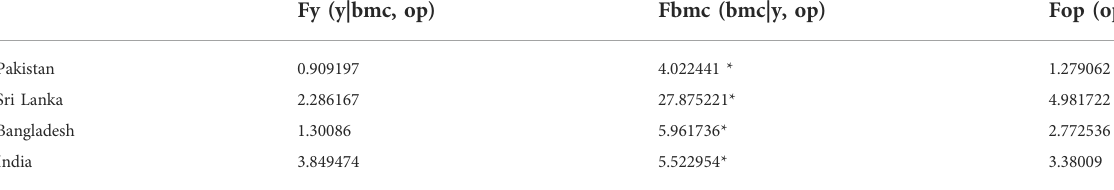
TABLE 2 Bound testing for co-integration.